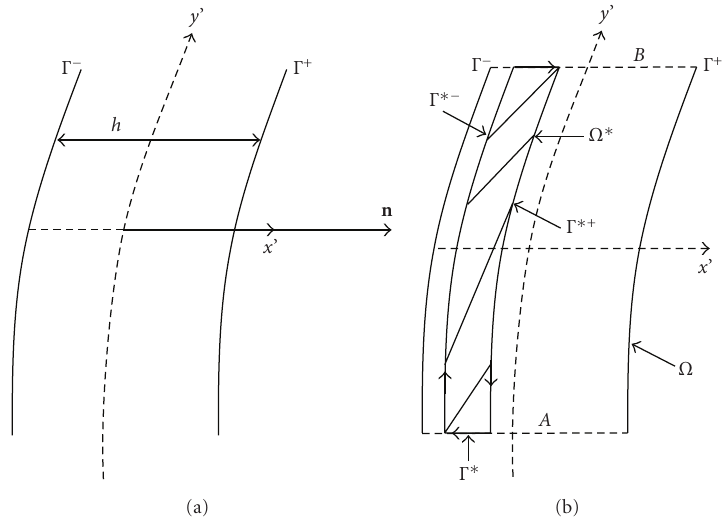
Figure 1: Analysis within the singular